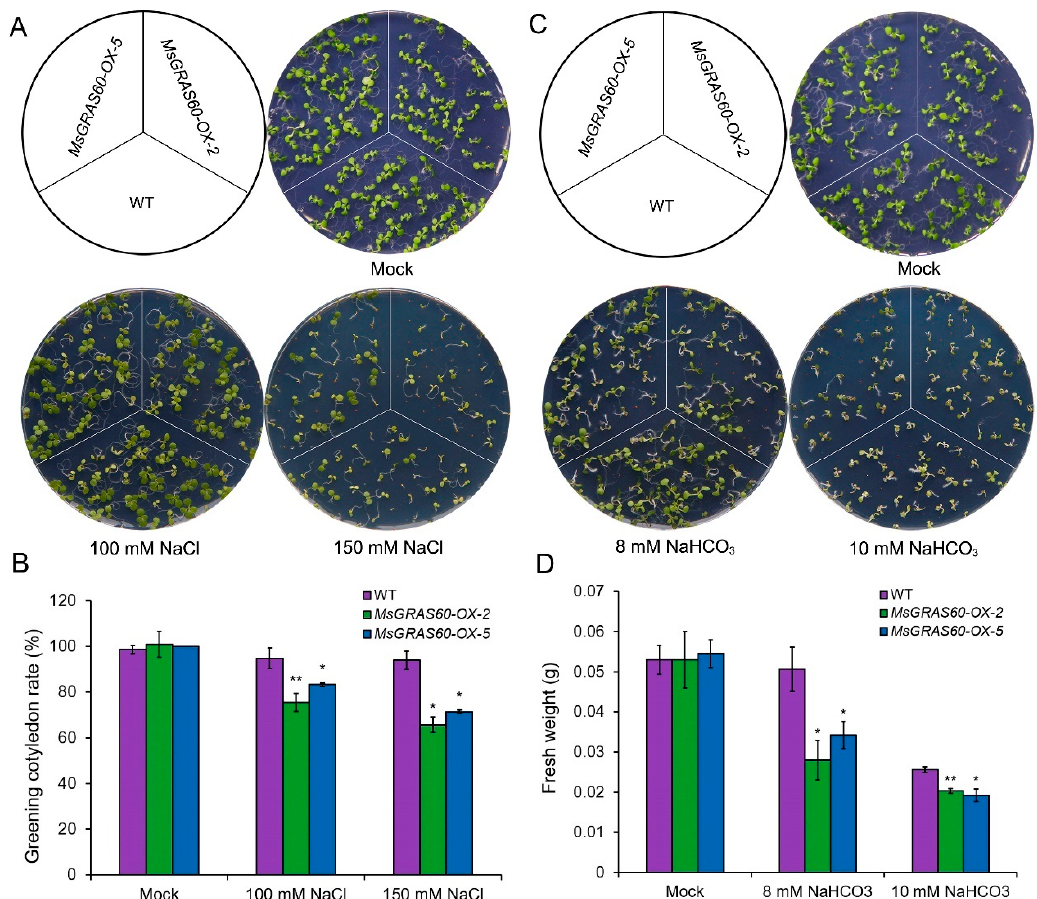
Figure 7. Salt and alkali stress tolerance assay of MsGRAS60 overexpression lines. ( A ) Germination assay of WT and MsGRAS60 overexpression lines under mock, 100 mM, and 150 mM NaCl treatments. ( B ) Quantification of greening cotyledon frequency in salt stress treatment. The greening cotyledon rate was calculated as the percentage of seedlings with green cotyledon out of the whole seedlings in three biological replicates. ( C ) Germination assay of MsGRAS60 transgenic lines and WT seedlings under mock, 8 mM, and 10 mM NaCHO 3 treatments ( D ) Quantification of fresh weight of seedlings under alkali stress treatment. At least 20 seedlings for each background were measured with three biological replicates. Values represent mean ± SE. Asterisks indicate significant differences between transgenic plants and WT based on Student’s t -test (* p < 0.05; ** p < 0.01).